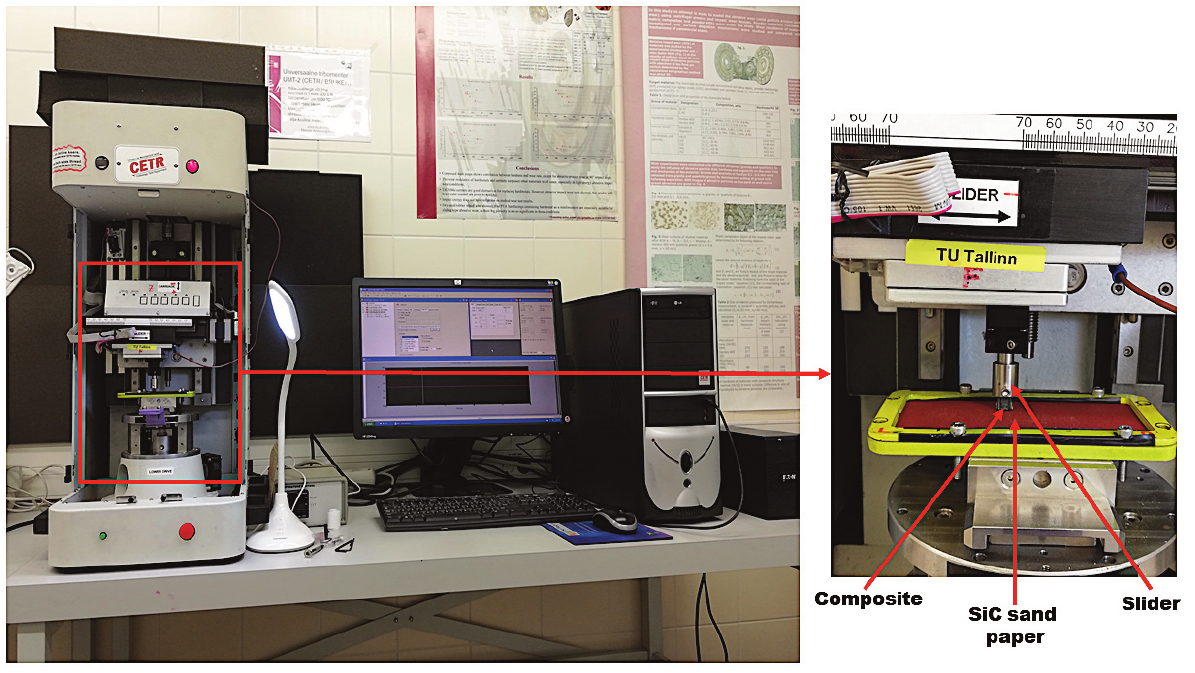
Fig. 1. Experimental setup for tribological